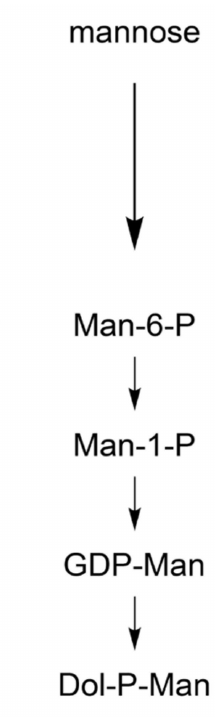
Figure 4. Importance of mannose phosphate isomerase in glucose-mannose